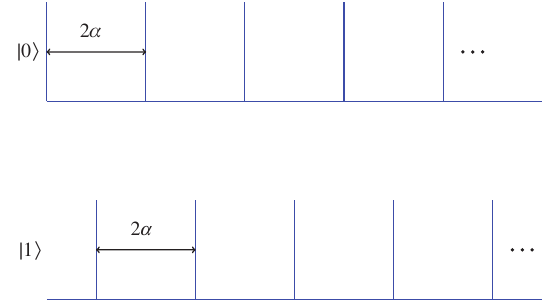
Figure 4: GKP encoding of qubits into a superposition of coherent states.